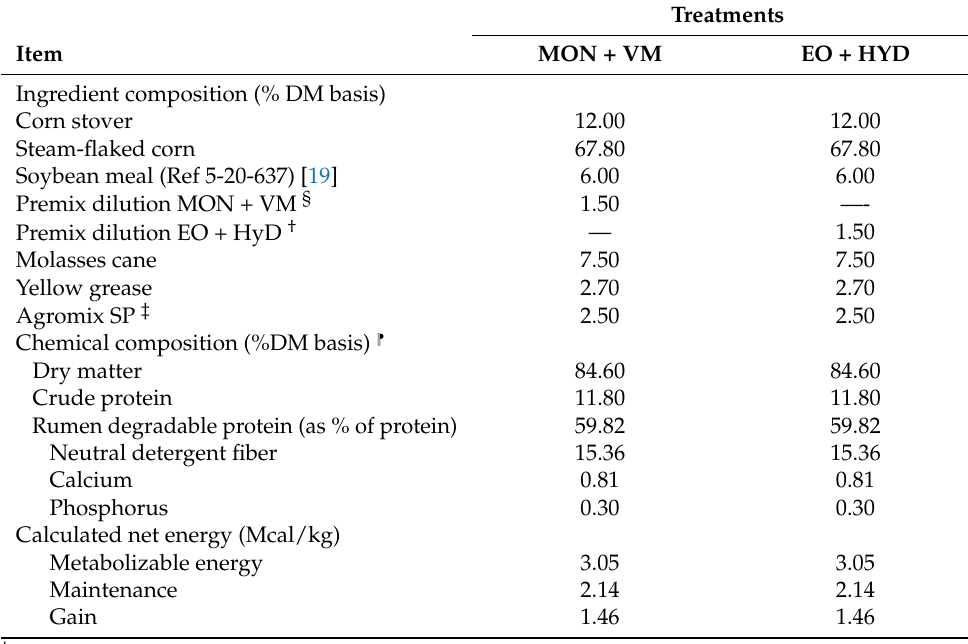
Table 1. Composition of basal diet fed by